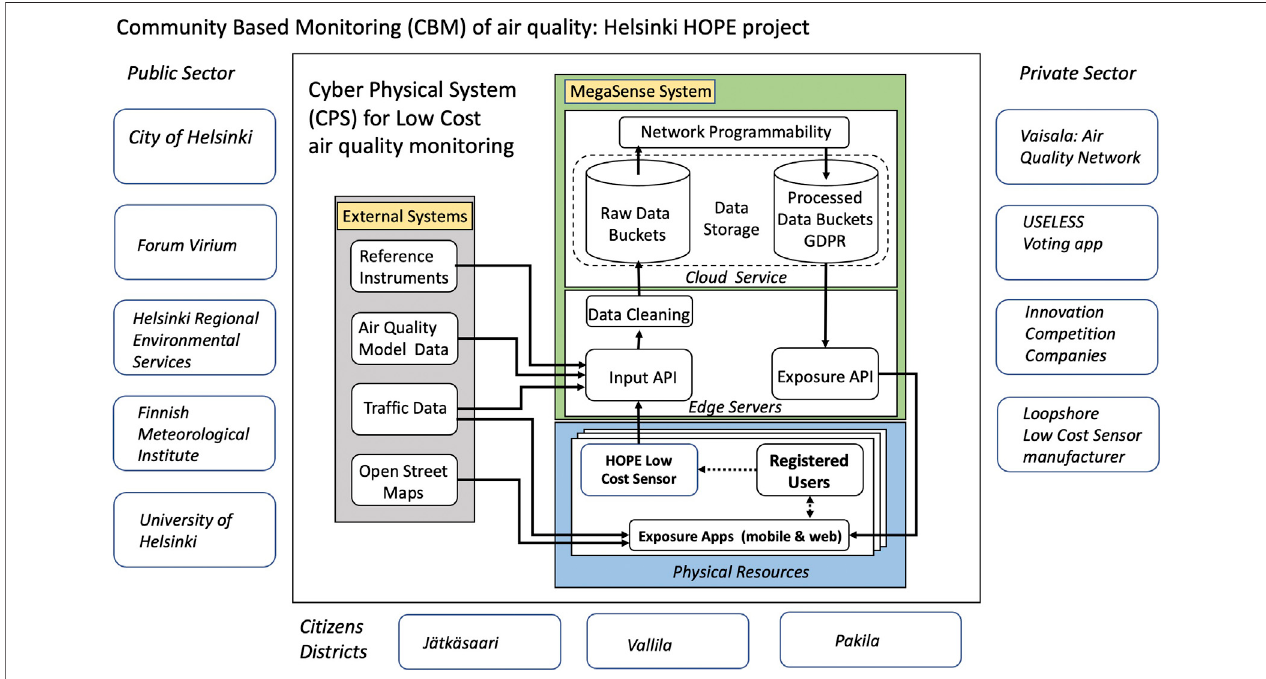
FIGURE 2 | Community-based monitoring with cyber-physical system architecture for air quality monitoring.